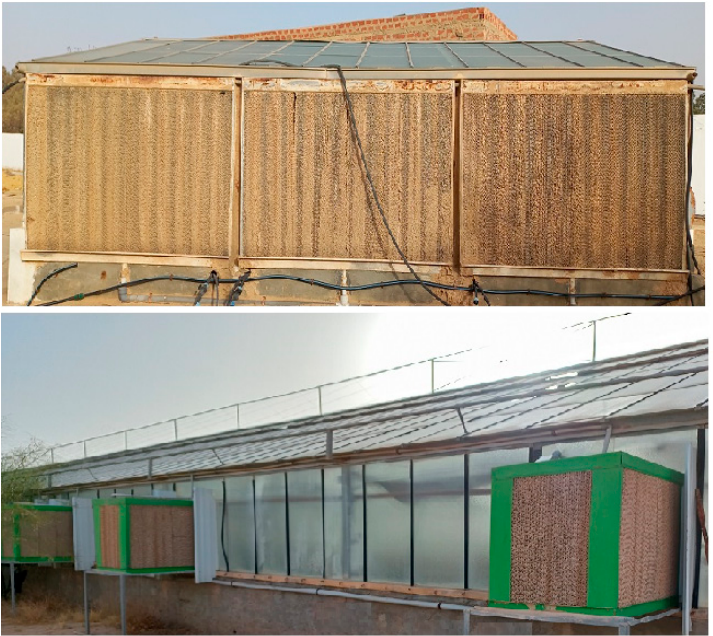
Figure 5. Fan and pad cooling systems for greenhouses at the Institute of Arid Regions (Kebili, Tu- nisia).